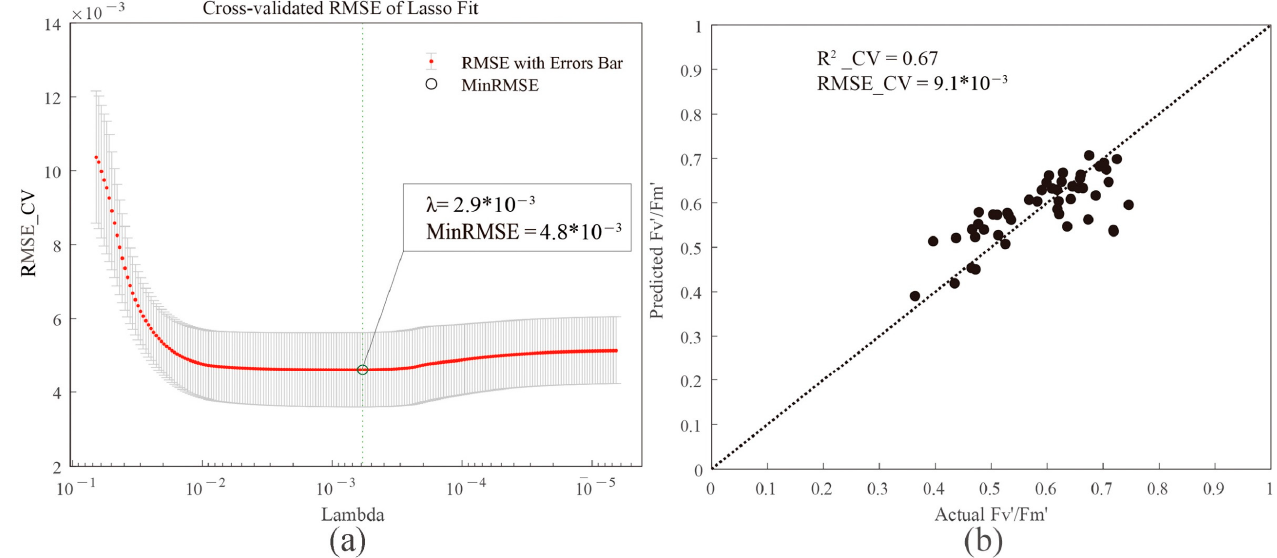
Figure 6. ( a ) Use of 10-fold cross-validation to determine the regular coefficient (lambda, λ ) of the Lasso model; ( b ) predicted and actual values of Fv'/Fm' by Lasso regression. Table 3. Spectral features were selected by Lasso regression. RegressionSpectral Lasso